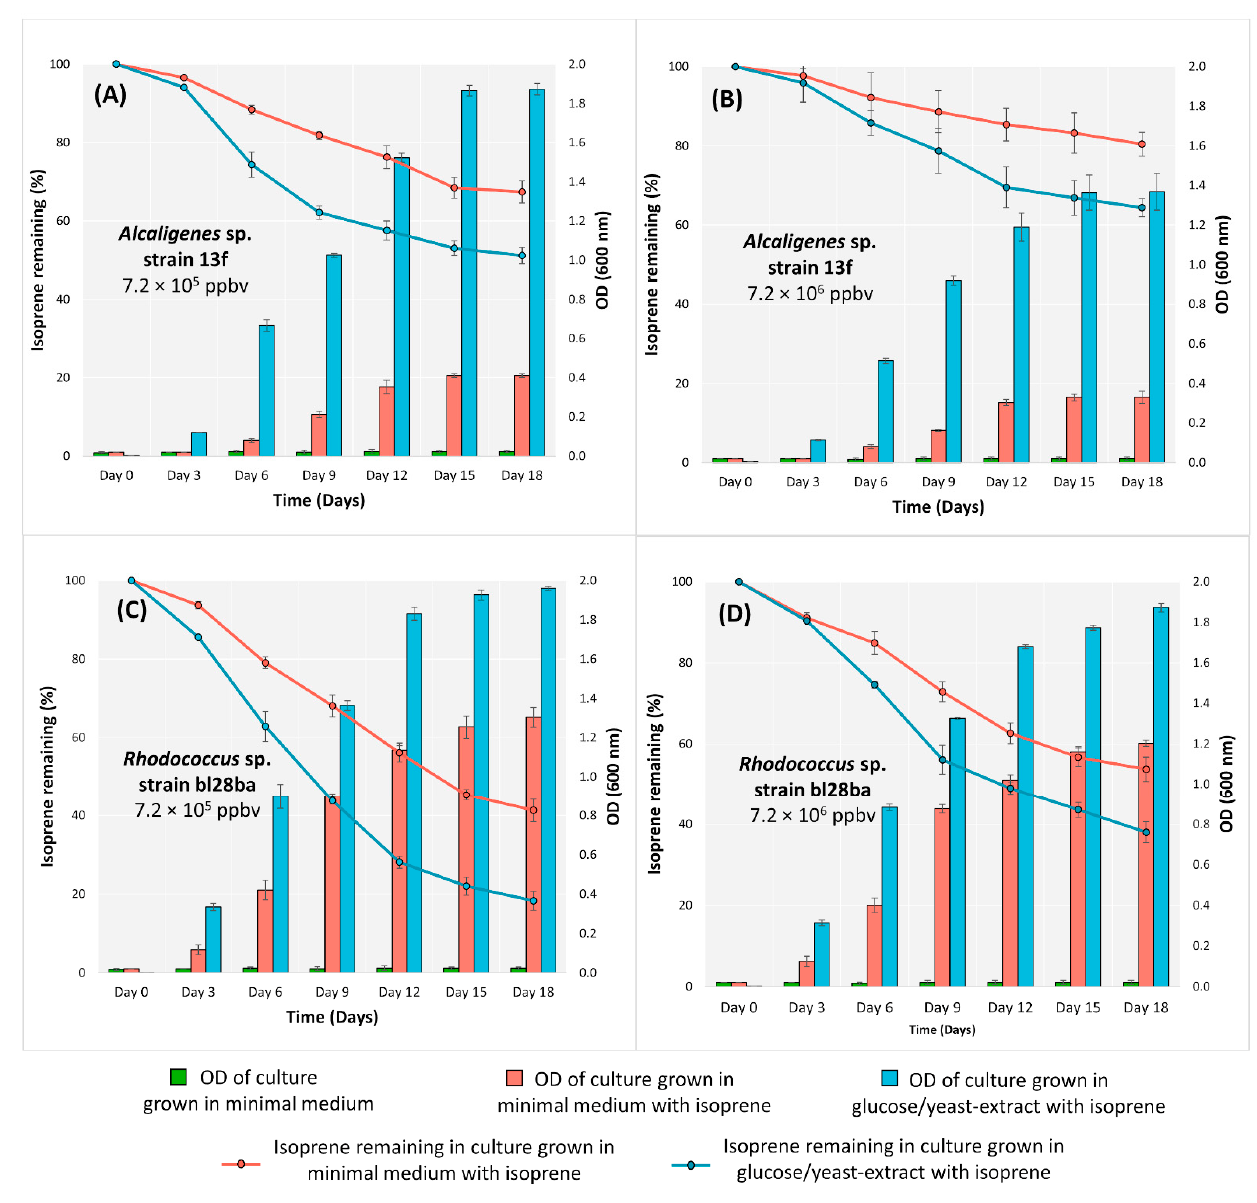
Figure 1. Growth and isoprene degradation by Alcaligenes sp. strain 13f ( A , B ) and Rhodococcus sp. strain bl28ba ( C , D ) in minimal medium and glucose/yeast-extract medium incubated with isoprene at two different concentrations over 18 days. Growth of each isolate was demonstrated by an in- crease in OD 600 , and isoprene degradation is shown by the percentage of remaining isoprene in the culture, n = 3. The error bars show ±